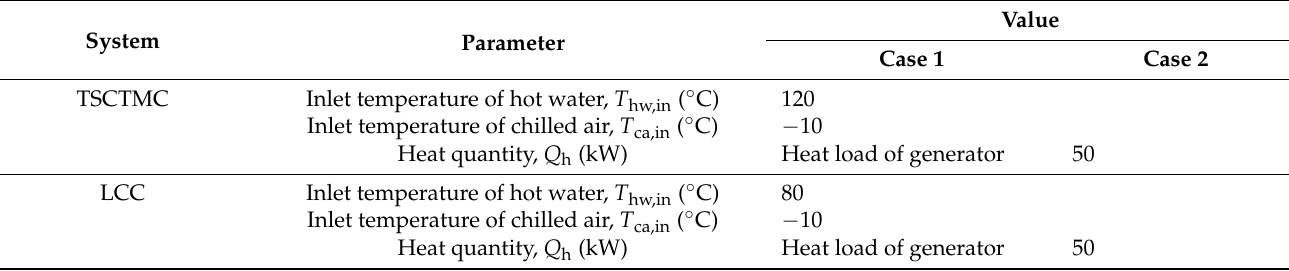
Table 6. Design and working conditions of the case